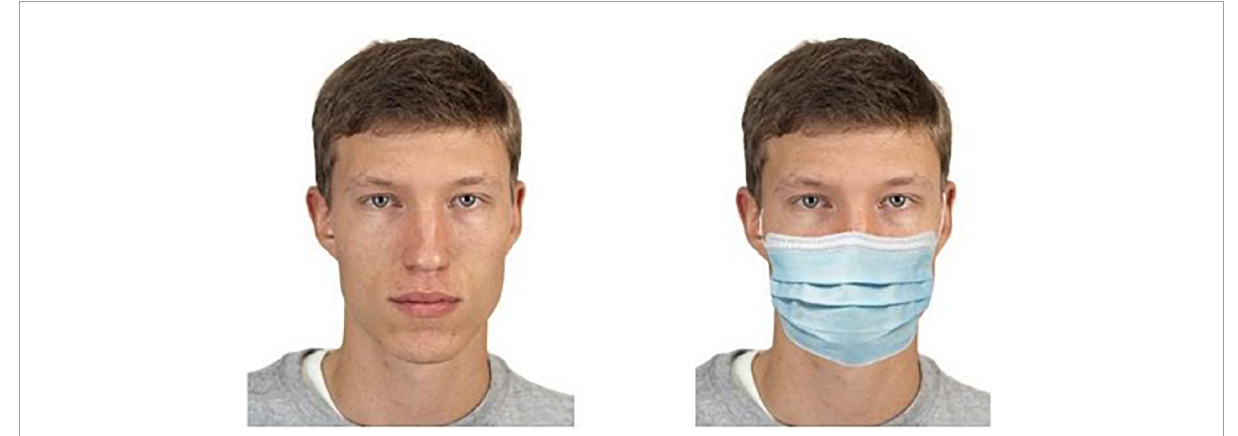
FIGURE1 Example of an original photo and its manipulated version with a superimposed mask. Reproduced with permission from the Chicago Face Database (Ma et al., 2015, p.